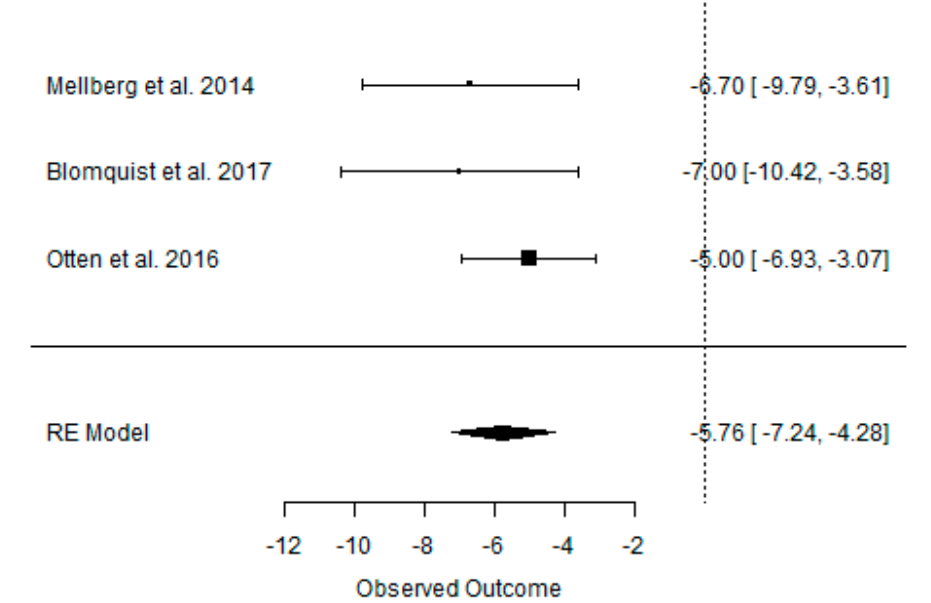
Figure A11. Forest plot of the effect of a CD on BM (kg) in the long term (weighted mean difference).